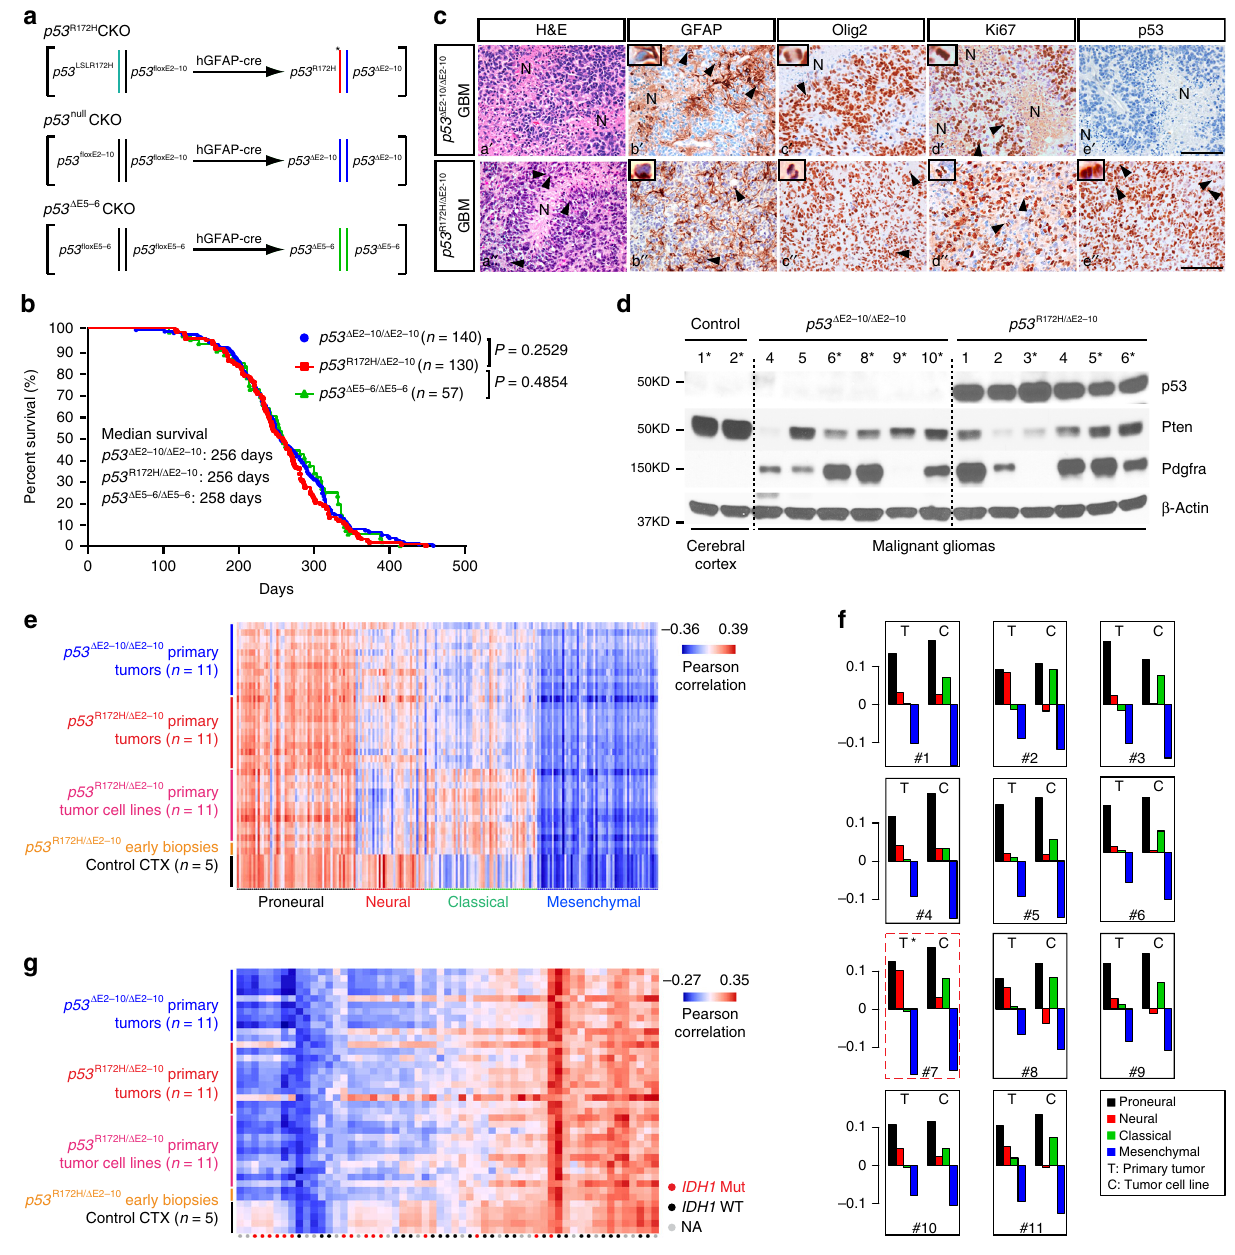
Fig. 1 p53 CKO GEM models for human primary TP53 -mutant IDH -WT GBM. a Genetic con fi gurations of hGFAP-cre-mediated recombination in the generation of three p53 CKO models. b Kaplan – Meier survival curves for three p53 CKO models. The Mantel – Cox (log-rank) test was used to statistically compare the overall survival. c Adjacent sections from representative brains with end-stage GBMs from p53 null CKO and p53 R172H CKO mice were stained for H&E, GFAP, Olig2, Ki67, and p53. Pseudopalisading cells were observed adjacent to necrotic areas (a ′ – e ′ , a ″ ). The arrows and inset show the tumor cell with perinuclear GFAP staining (b ′ , b ″ ). Arrows and insets show abnormal mitotic fi gures at anaphase and/or metaphase in tumors (c ′ , d ′ , c ″ – e ″ ). N necrosis. Scale bars: 50 µ m. d Western blotting analyzed p53, Pten, and Pdgfr α levels in parenchymal gliomas/GBMs from p53 null CKO ( n = 6) and p53 R172H CKO ( n = 6) mice. Normal adult cortical tissues from hGFAP-cre + ; p53 fl oxE2 – 10/ + ( n = 2) mice were used as controls (Ctr). “ * ” marks the samples with both western blotting ( d ) and microarray (Supplementary Fig. 1n, red points) analysis. Source data are provided as a Source data fi le. e Gene expression pro fi les of primary tumor tissues of p53 null CKO mice ( n = 11), paired primary tumor tissues and primary tumor-derived cell lines of p53 R172H CKO mice ( n = 11), primary tumor-derived cell lines from early stage p53 R172H CKO biopsies ( n = 2), and normal cortical tissues (CTX, n = 5) were compared to human GBMs ( n = 202) using the classi fi cation system established by Verhaak et al. 23 . Red indicates strong sample-wise Pearson correlation; blue indicates the reverse. See methods for details. f Gene expression pro fi les of paired p53 R172H CKO primary tumor and primary tumor-derived cell lines were scored based on their gene expression similarity to four human GBM subtypes. Positive values indicate similarity. Primary tumor #7 (red box, *) was documented by histology with normal tissue contamination prior to microarray analysis. g Gene expression pro fi les of the same set of samples from ( e ) were compared to human proneural subtype GBMs with or without IDH1 mutations (red or black dots). See methods for